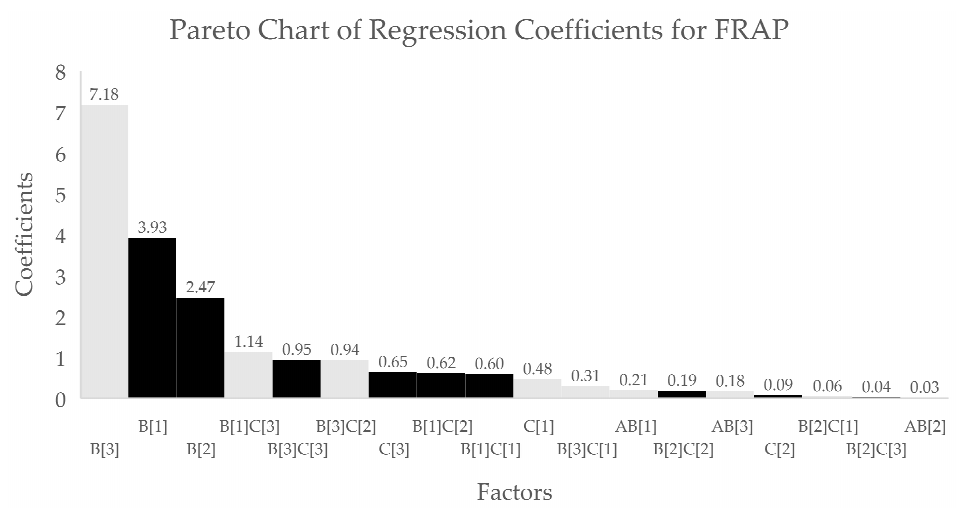
Figure 3. Pareto chart of regression coefficients for FRAP antioxidant activity data. X-axis indicates the different factors (A[ n ] = pulverisation, B[ n ] = solvent type, C[ n ] = extraction process, AB[ n ] = interaction of pulverisation and solvent, B[ n ]C[ n ] = interaction of solvent type and extraction process) while the values in the left x-axis indicate the coefficient values for the corresponding factors. Black bars indicate positive effect, while white bars indicate negative effect on DPPH antioxidant activity.